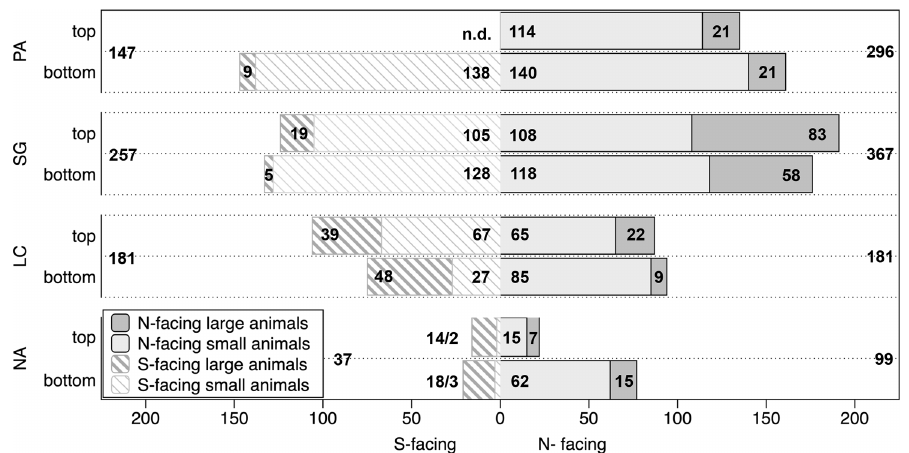
Figure 5. Overview of number of measured burrow entrances per plot specification across study sites. The data are presented per top/bottom position on slopes as well as N(orth)- or S(outh)-facing aspect. The numbers within the bars indicate the number of entrances found at the respective slope position per animal group, the numbers outside of the bars are total values for the respective slope; the depicted data are pooled from all three field campaigns: 2016, 2017 and 2018. PA – NP Pan de Azúcar, SG – Santa Gracia, LC – NP La Campana, NA – NP Nahuelbuta, n.d. – not determined. (Note that the spatial distribution of the plots in NP Pan de Azúcar was not as uniform as at the other sites, and the numbers contain three plots north-facing (one top, two bottom) and one plot south-facing (bottom).)